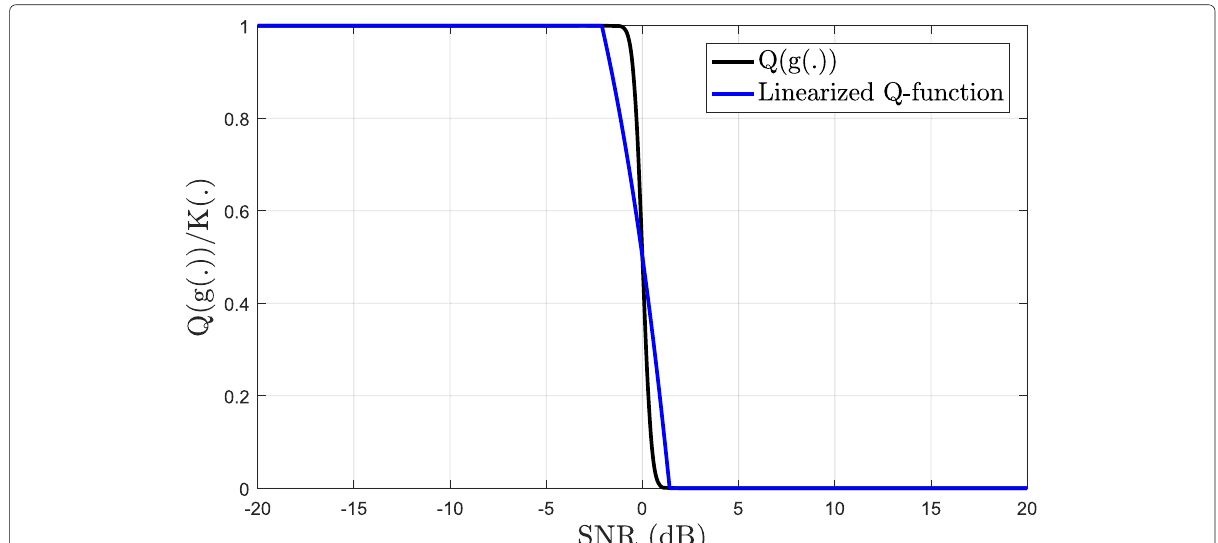
Fig. 2 Accuracy of linearized Q-function compared to the original Q-function. This figure illustrates the accuracy of Q-function linearization applied in closed form expression of outage probability